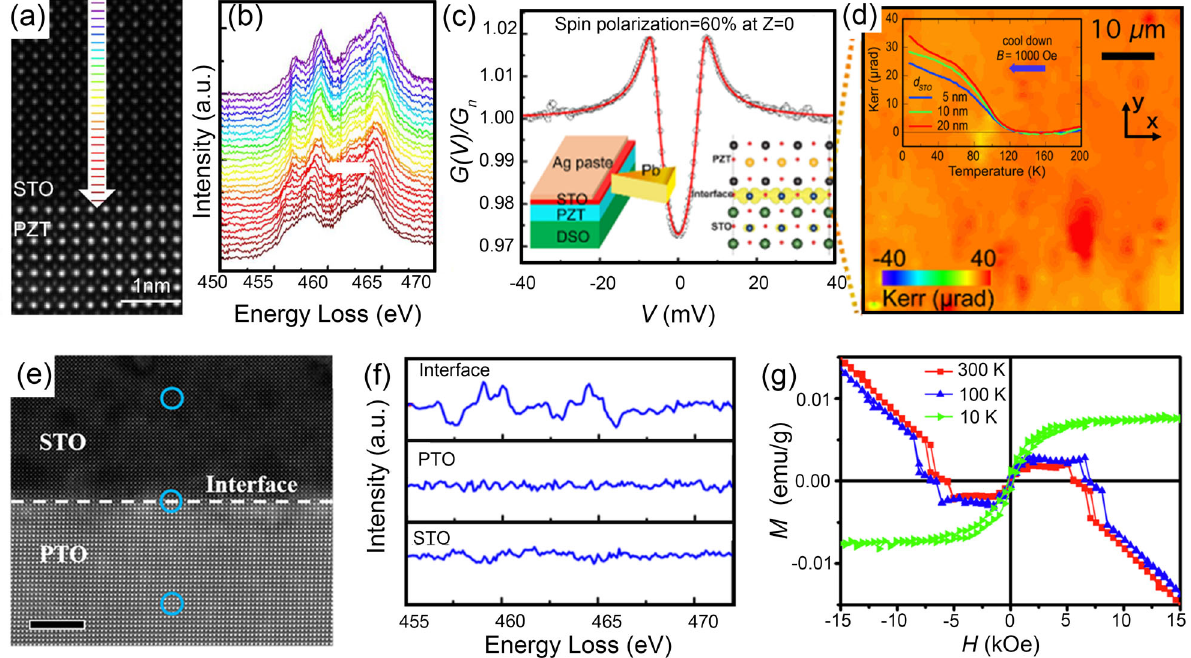
Fig. 5 Polarization-induced ferromagnetism at the ferroelectric/insulator interface. a – d The conductance of SP-2DEG at STO/PZT interface. a HAADF-STEM image and ( b ) corresponding EELS spectra in STO/PZT(/DSO) heterostructure. The broadened peaks in STO near the interface are attributed to the presence of Ti 3 + near the STO/PZT interface. c Representative Andreev spectra (open circles) of point contact between Pb superconductor and STO/PZT interface with the best fi ts to the modi fi ed Blonder – Tinkham – Klapwijk (BTK) model (solid curves), where T = 1.51 K, P = 0.50, Δ = 1.31 meV, r E = 3.76, Z = 0.21, and R = 899 Ω . The inset is the schematic of point contact established at the STO/PZT interface. d 1000 Oe cool-down for three (5, 10, 20 nm) STO/50 nm PZT/DSO sample and its Kerr signal image mapping at 4 K under 1000 Oe fi eld, showing uniform ferromagnetism signal distribution. Scale bar, 15 μ m. Reproduced with permission from ref. 80 . Copyright [2018] {Springer Nature}. e – g Ferromagnetism of STO/PTO heterointerface. e HAADF-STEM image of STO/PTO interface. The EMCD was taken in the marked areas ( f ). The EMCD patterns of STO/PTO heterointerface. g M − H curves of STO/PTO heterostructures at different temperatures. Reproduced with permission from ref. 104 . Copyright [2020]